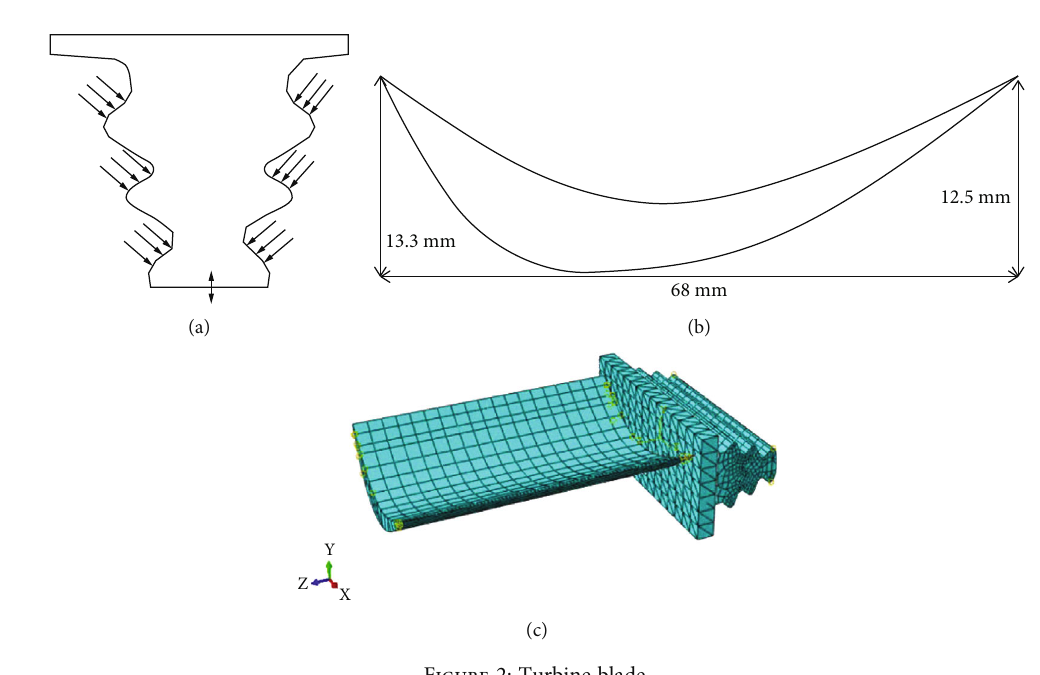
Figure 2: Turbine blade.